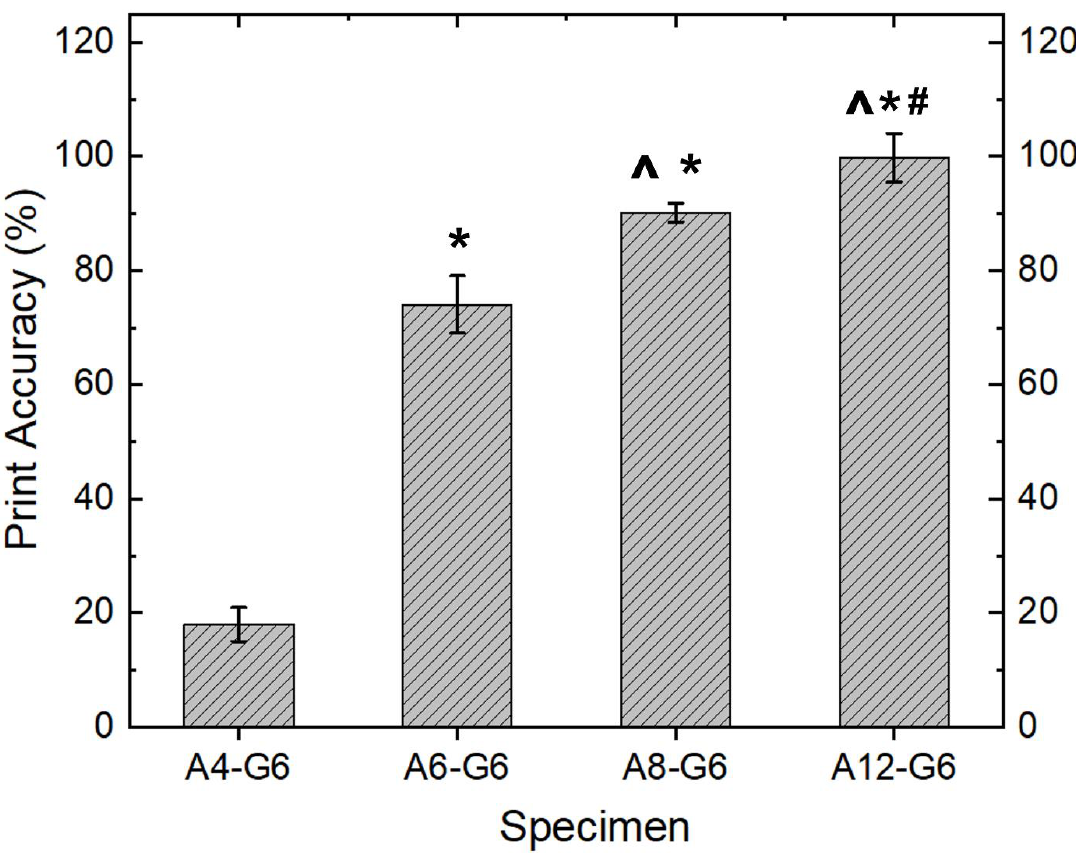
Figure 4. Print accuracy of the varying printed constructs. * indicates p < 0.05 compared to A4-G6. ^ indicates p < 0.05 compared to A6-G6. # indicates p < 0.05 compared to A8-G6.